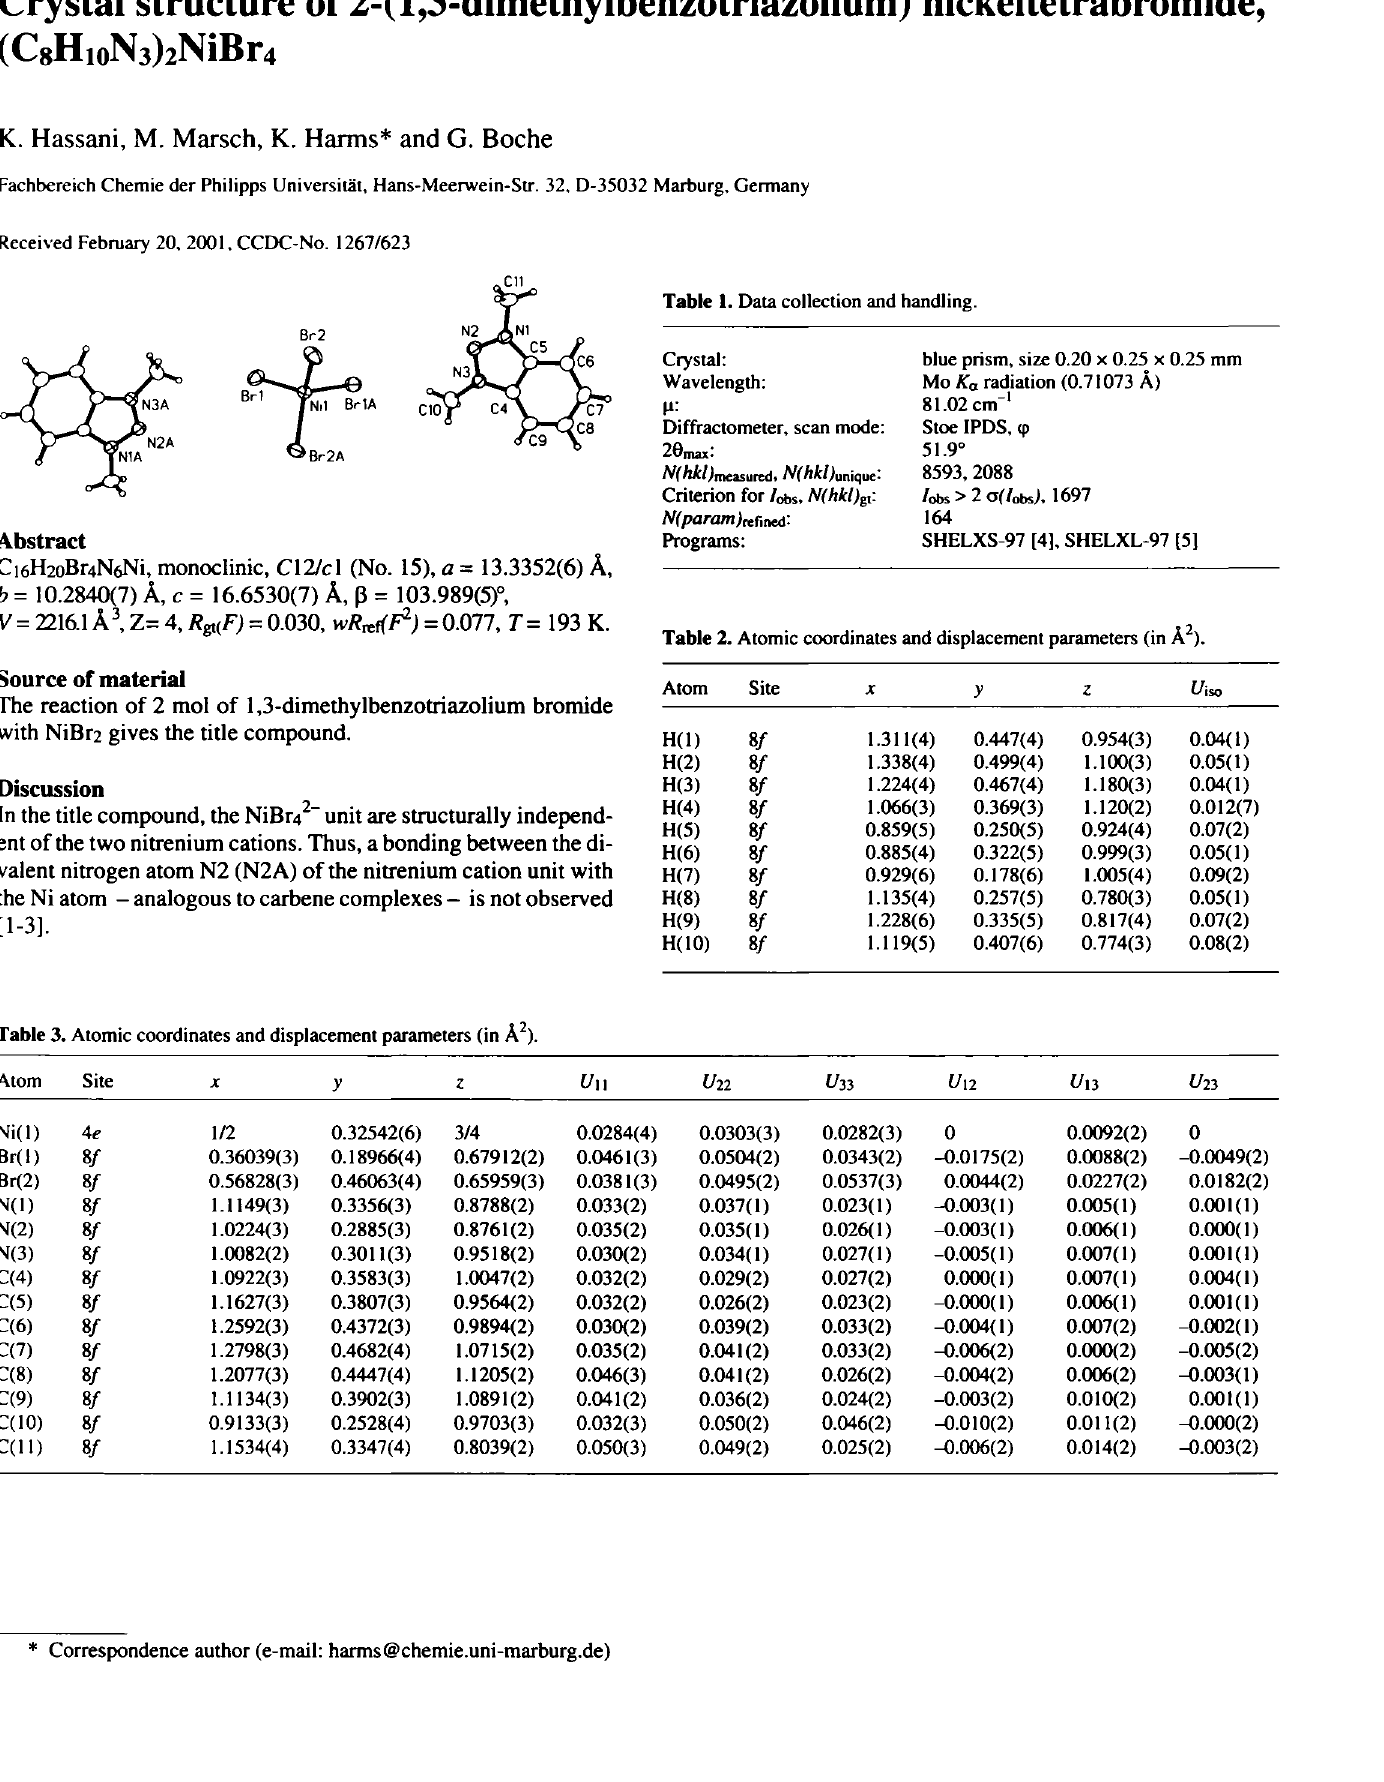
Table 1. Data collection and handling.